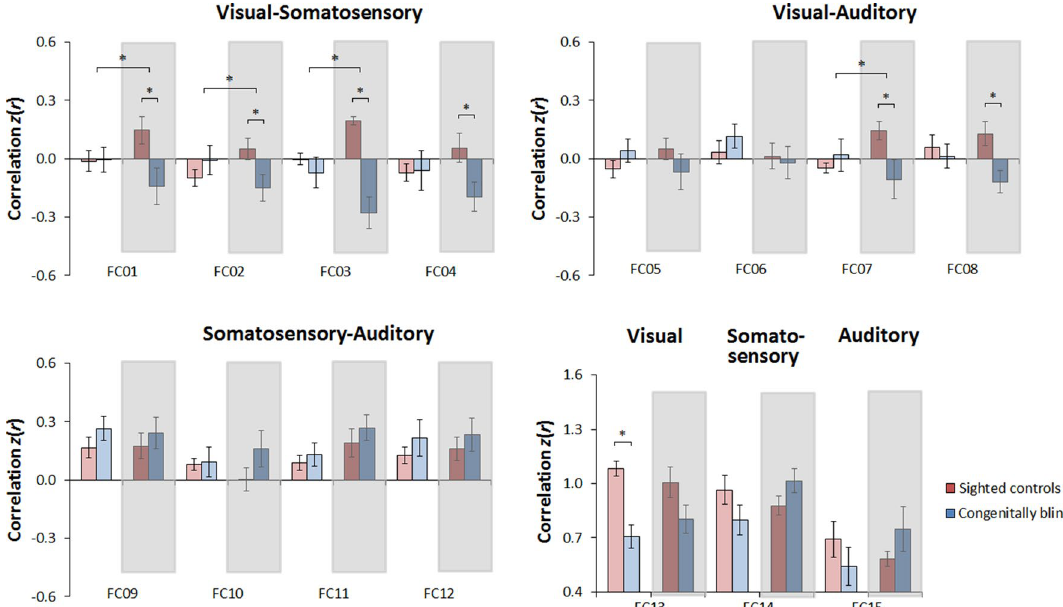
Figure 3. Effects of group in Study 2, plotted separately by resting state condition (gray insets highlight the eyes closed condition). Shown is the average functional connectivity with the standard error of the mean in the sighted group (red bars) and in the congenitally blind group (blue bars), plotted separately for the eyes open condition (light red and light blue bars) and the eyes closed condition (dark red and dark blue bars), for each instance of functional connectivity examined (for details, see Table 4). Note that this figure is equivalent to Fig. 2; here, the bars were reorganized to depict the effects of group separately by resting state condition.